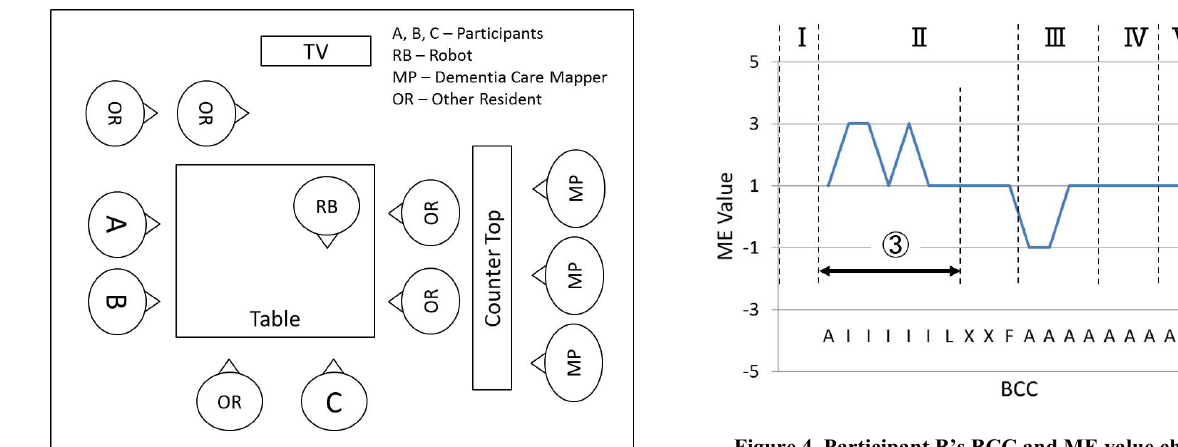
Figure 4. Participant B’s BCC and ME value changes